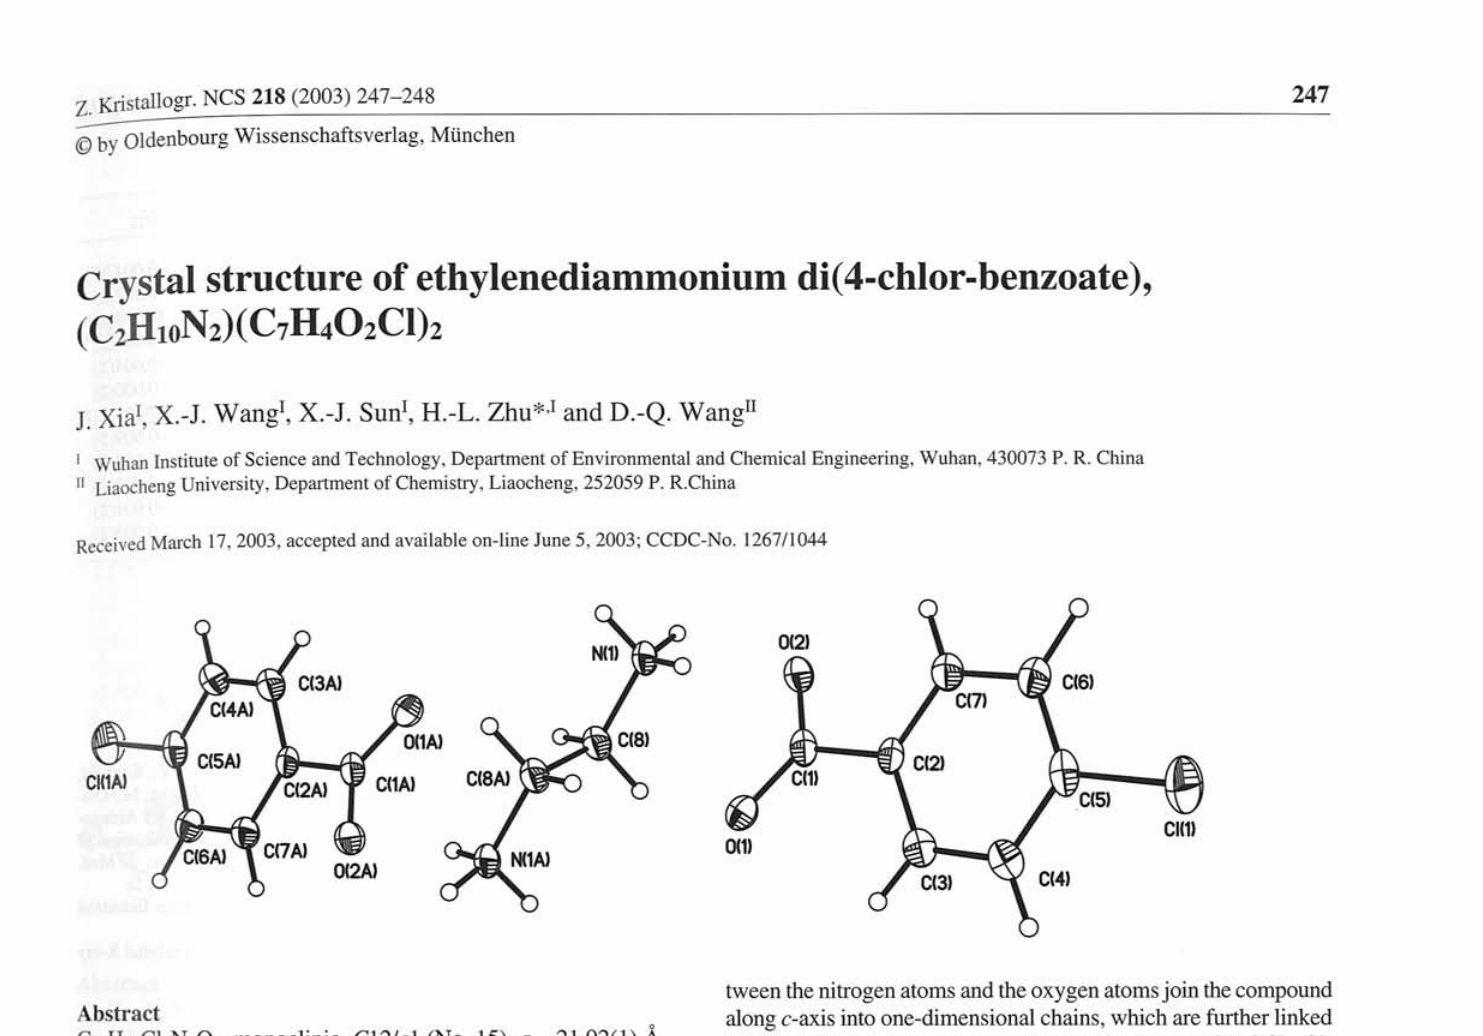
Table 1. Data collection and handling.